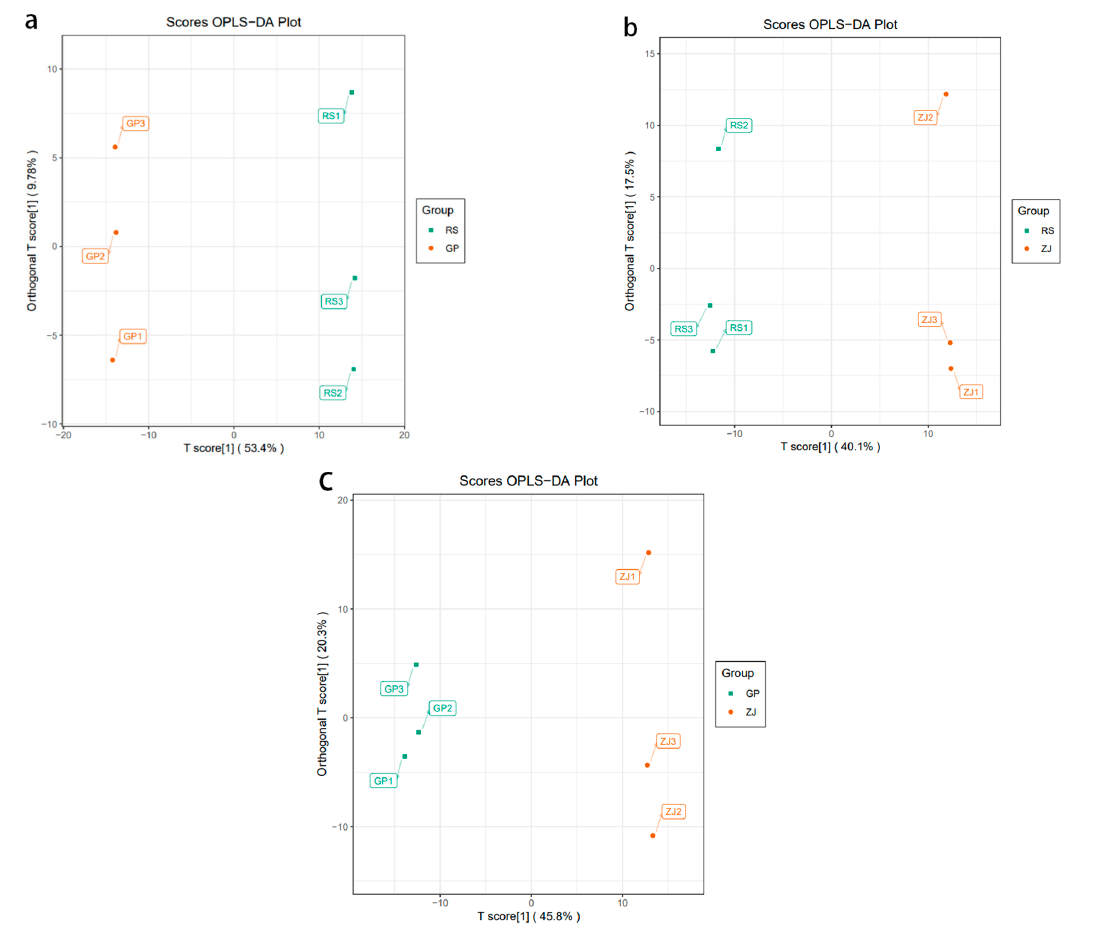
Figure 4. Score plots of OPLS-DA: ( a ) RS vs. GP; ( b ) RS vs. ZJ; ( c ) ZJ vs. GP. The model is valid when Q 2 > 0.5. The X -axis is the principal predictive component, and the Y -axis is the principal orthogonal component.